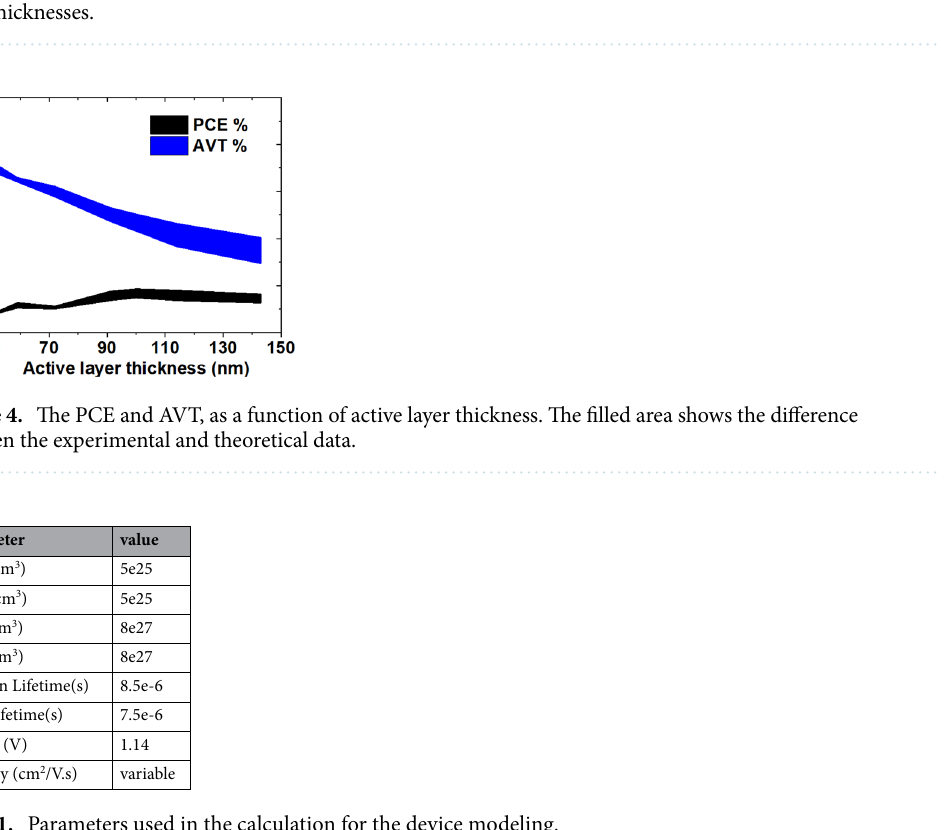
Table 1. Parameters used in the calculation for the device